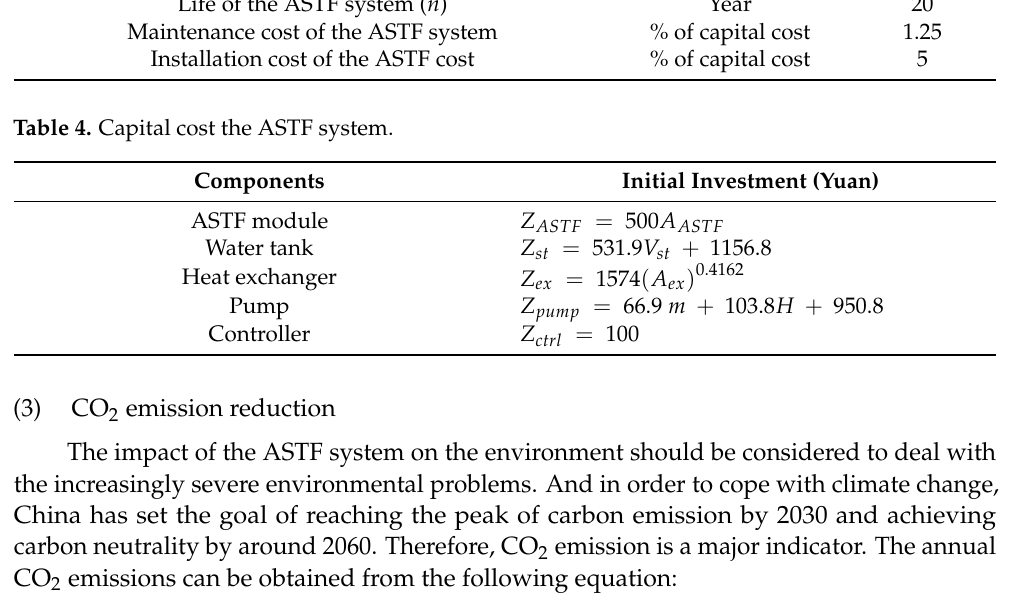
Table 5. Climate data for the three cities [31].